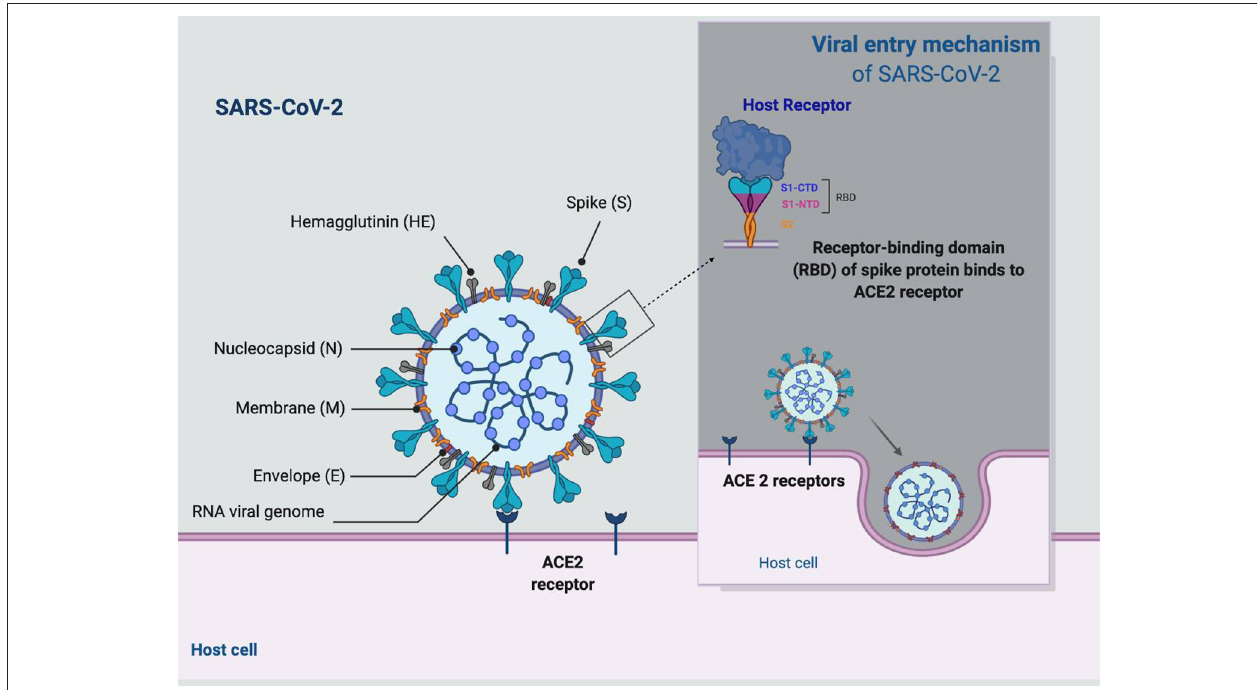
FIGURE 2 | Diabetes as a risk factor for